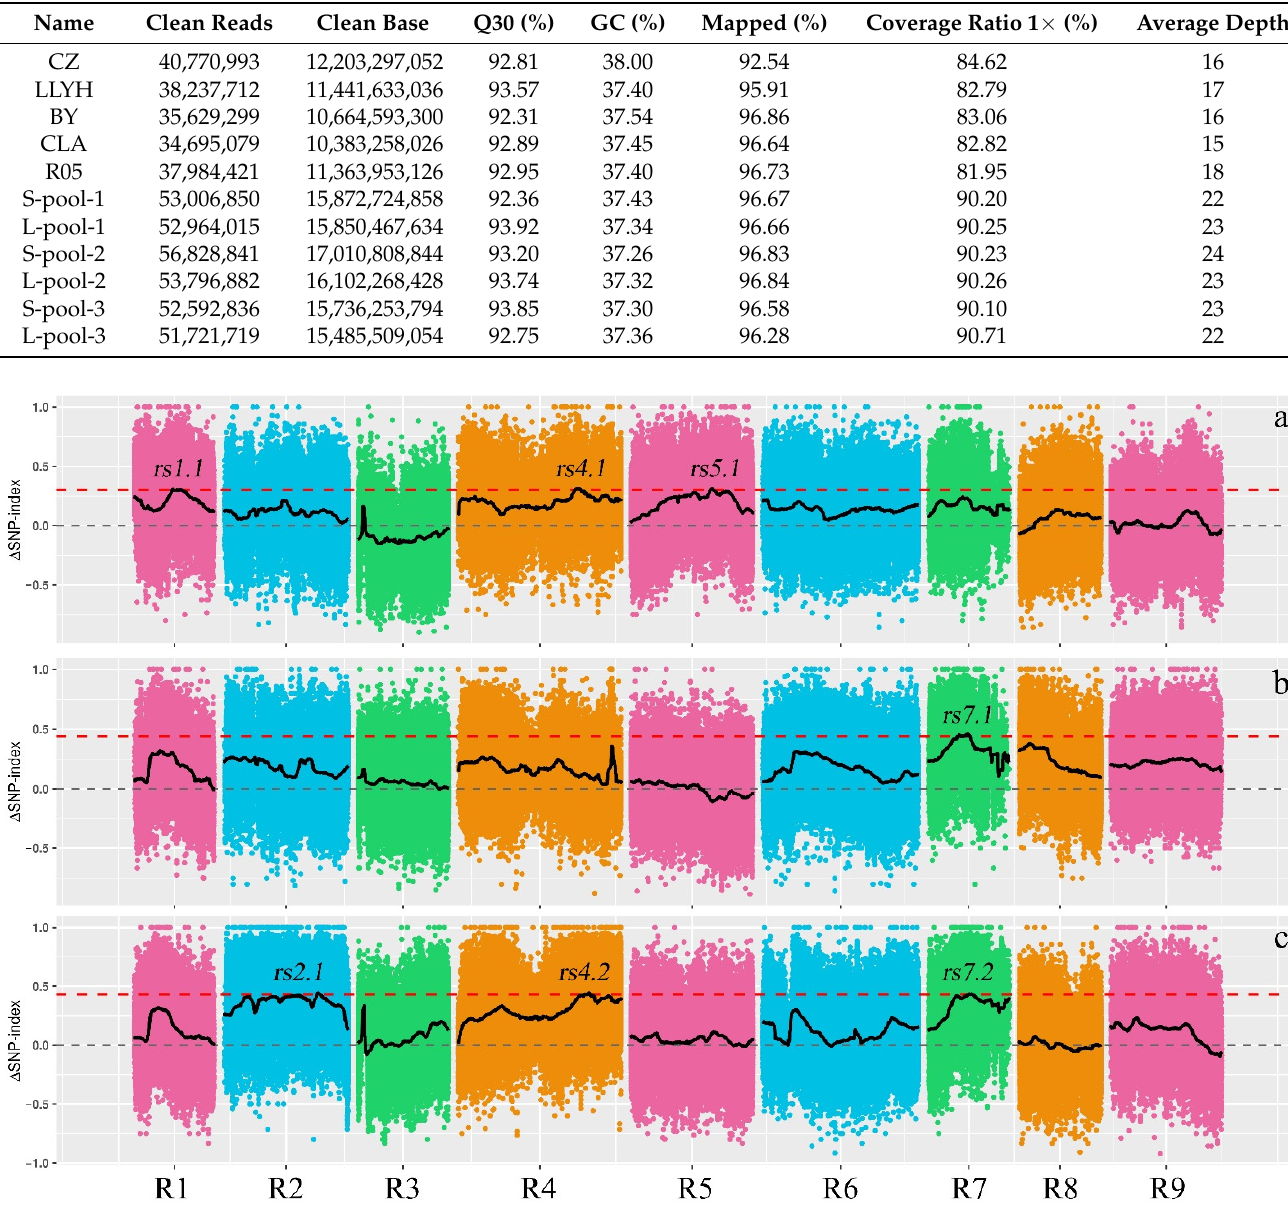
Table 3. Statistics of the sequencing data for the five parents and extreme pools.